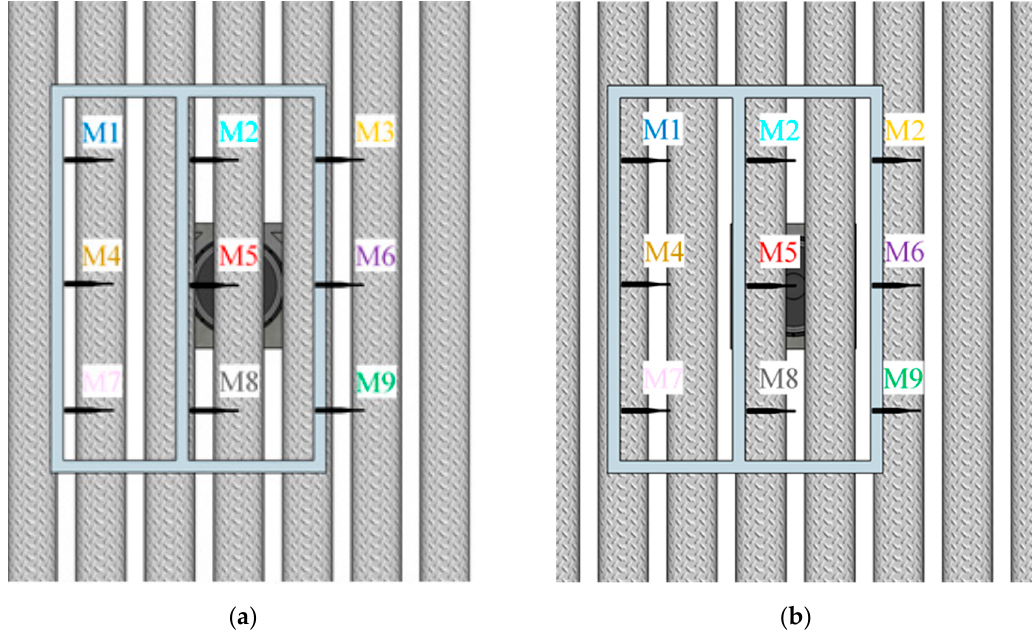
Figure 8. Positions of the microphone grid in two different configurations: ( a ) Configuration A, the middle column of microphones faces the centre of the cylinders; ( b ) configuration B, the middle column of microphone grid faces the centre of the space between two adjacent cylinders.